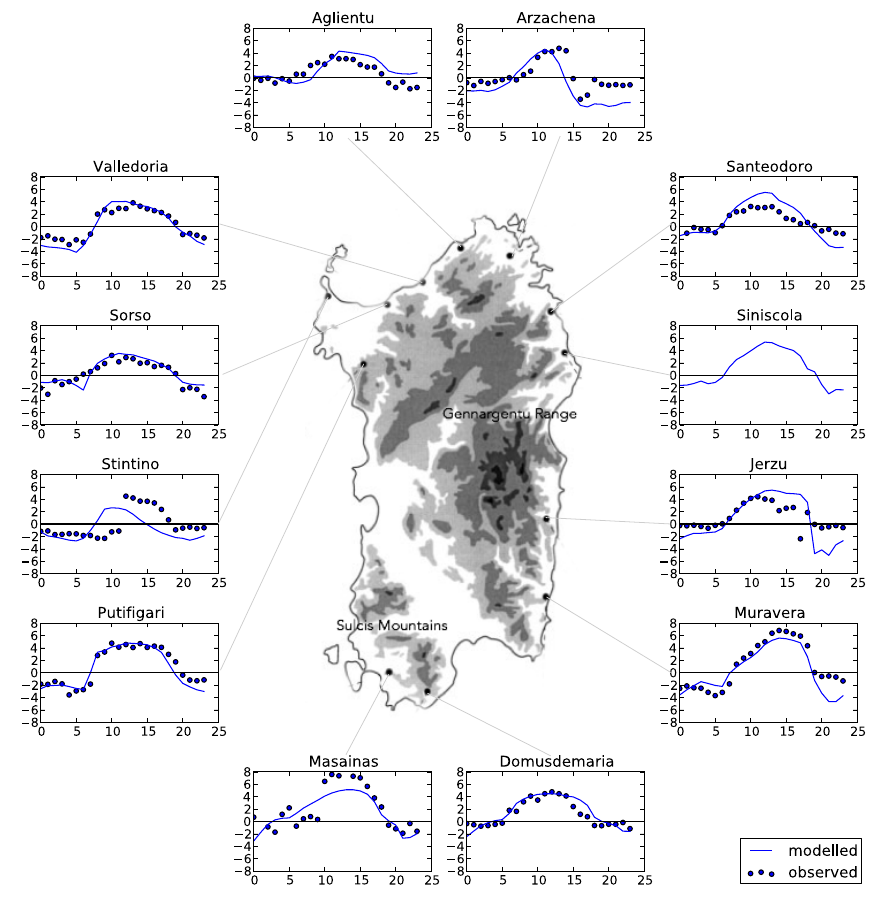
Figure 3. Diurnal evolution of onshore wind at 10m over Sardinia on 21 June 1998.